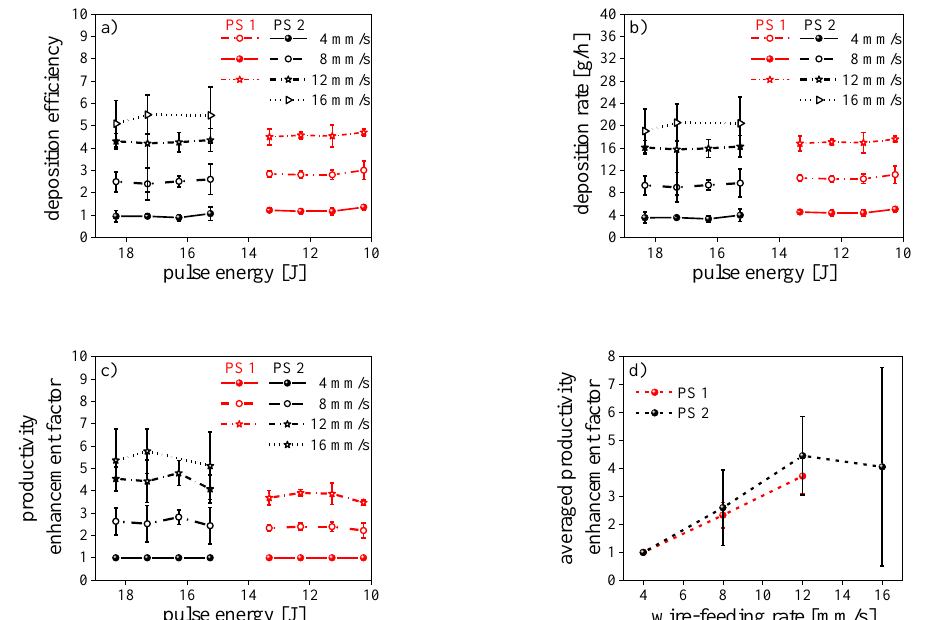
Figure 16. Hot-wire power averaged deposition efficiency ( a ) and rate ( b ) as well as the productivity enhancement factor ( c ) as function of pulse energy for the applied wire-feeding rates and pulse shapes (PS) and the pulse energy averaged productivity enhancement factor ( d ) as function of wire-feeding rate.